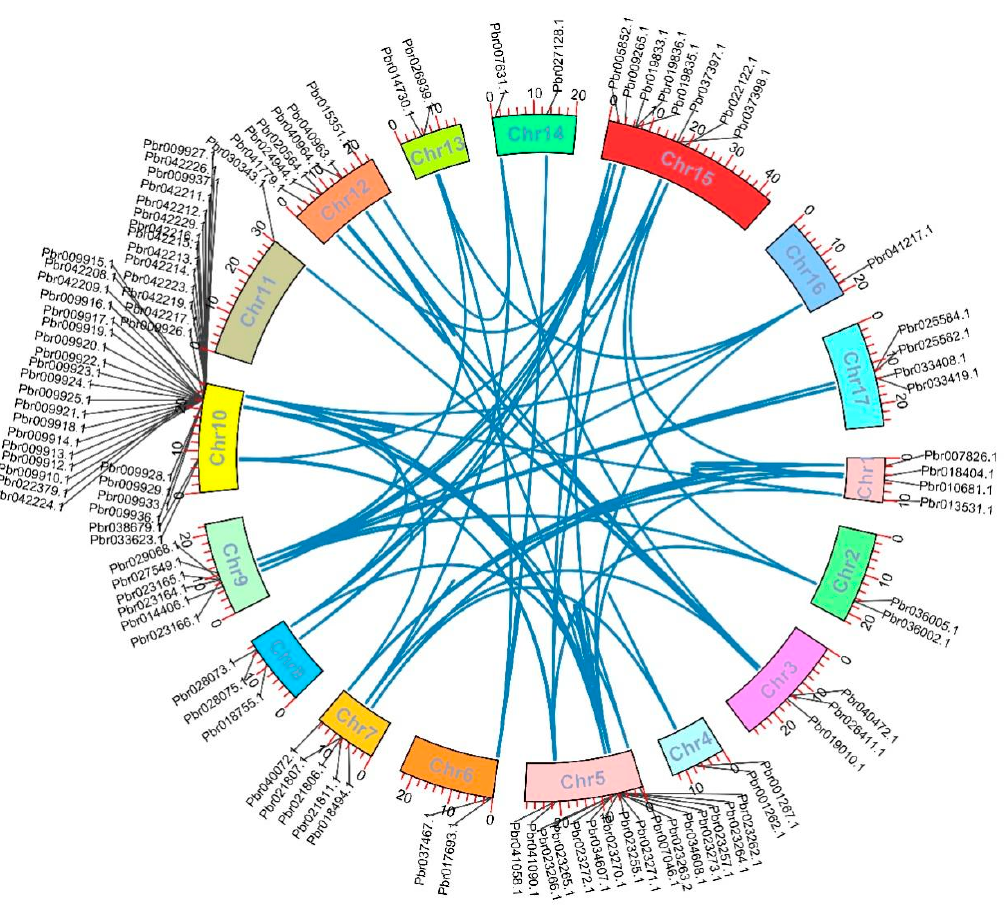
Figure 4. Analysis of duplication type and chromosomal localization of SAUR gene family in ‘Dangshansu pear’. Duplicated gene pairs are linked with a blue line.